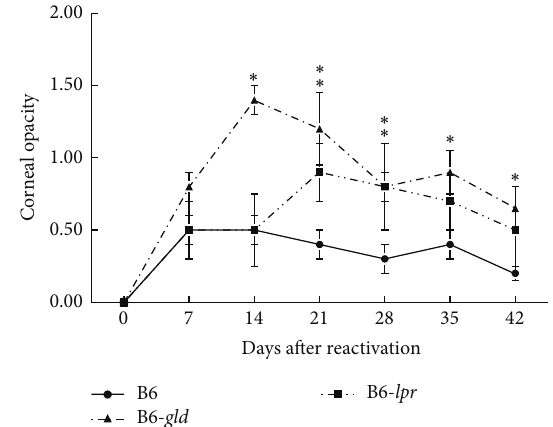
Figure 3: Similar patterns of disease were seen in C57BL/6 (B6) mice carrying the gld and lpr mutations following UV-B reactiva- tion. Eyes of B6 wild-type ( 𝑛 = 20 ), B6- lpr ( 𝑛 = 15 ), and B6- gld ( 𝑛 = 15 ) mice were infected with 10 6 pfu of HSV-1, McKrae strain. Six weeks following infection mice were irradiated with UV- B to reactivate the latent infection. Corneal opacity was measured and compared between these strains of mice. ∗ Significant virus- induced corneal opacity was observed for B6- gld ( 𝑃 < 0.01 –0.001) at days 14–42 when compared to B6 controls. B6- lpr mice displayed significantly more opacity than did B6 controls at days 21 and 28 ( 𝑃 < 0.05